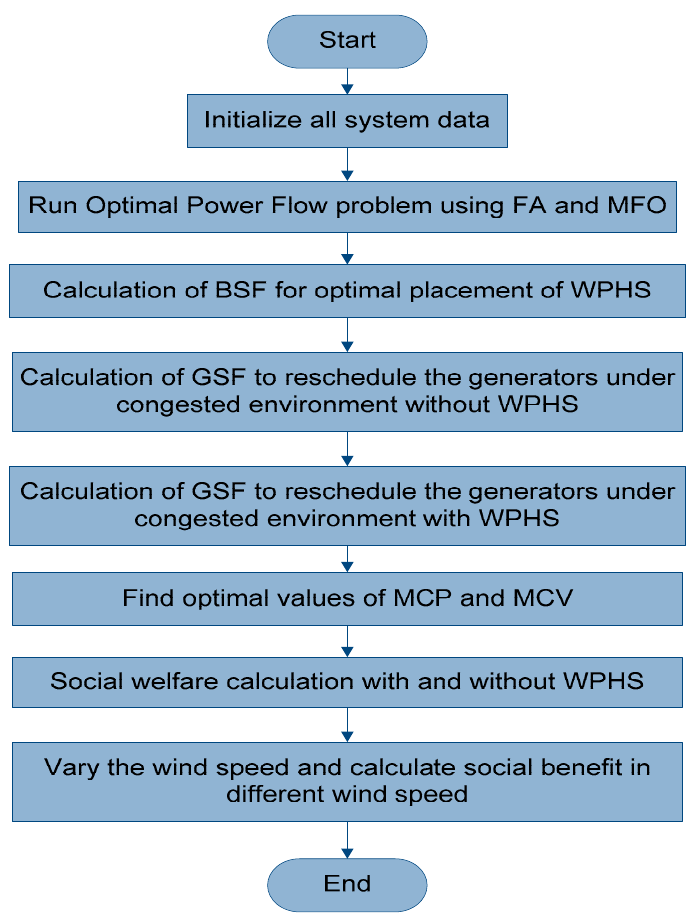
Figure 1. Indicating flow chart of the proposed market-clearing power simulation problem.